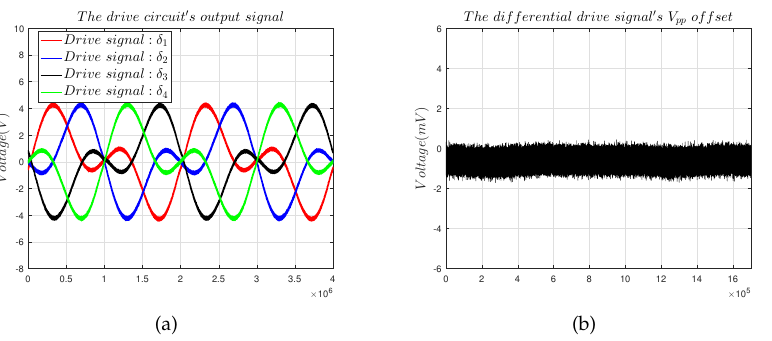
Figure 17. Signal processing circuit output curves: ( a ) driver circuit output curves; ( b ) sensing circuit output curves.